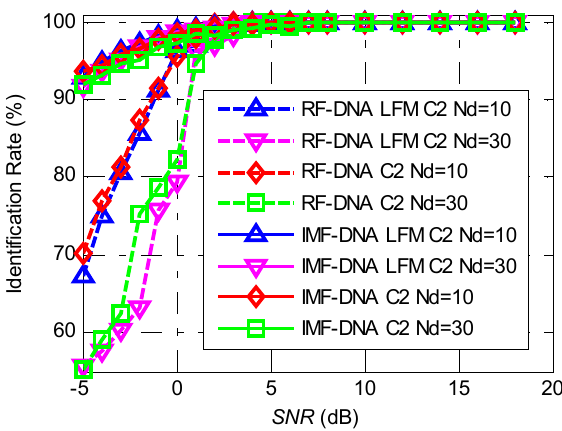
Figure 8. A comparison of the identification performance of the RF-DNA and IMF-DNA algorithms for LFMs with different envelopes being classified into two classes and all the signal sources being classified into two classes.